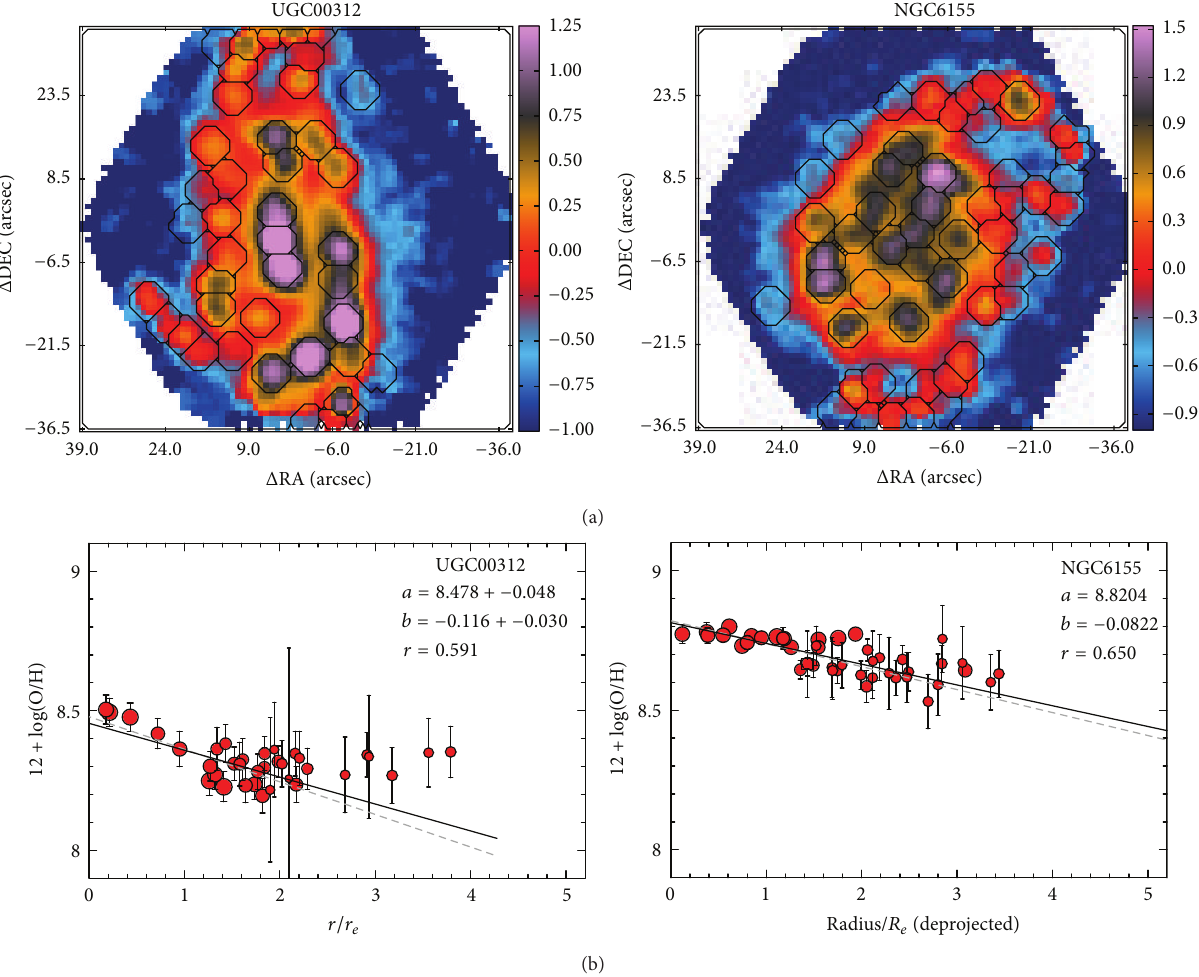
Figure 5: (a) IFS-based H 𝛼 maps, in units of 10 −16 erg s −1 cm −2 arcsec −2 , derived for two representative galaxies of the sample (color images), together with the detected Hii regions shown as black segmented contours. (b) Radial distribution of the oxygen abundance derived for the individual Hii regions with abundance errors below 0.15 dex, as a function of the deprojected distance (i.e., corrected for inclination), normalized to the effective radius, for the same galaxies. The size of the circles is proportional to the H 𝛼